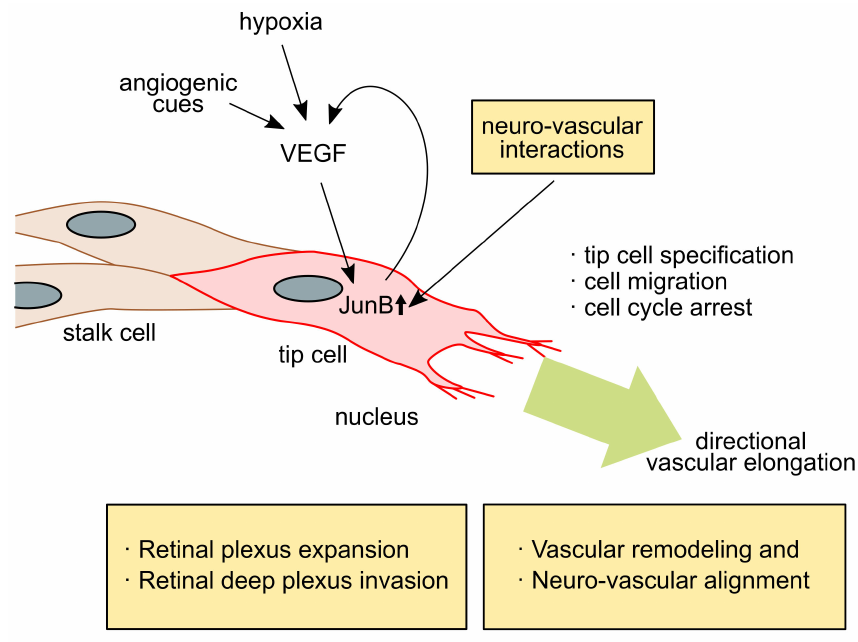
Figure 1. In the event of angiogenesis in embryonic skin and retina, endothelial cells respond to angiogenic cues, such as hypoxia or other signals, to produce new vessel branches at the angiogenic frontier. The vascular endothelial growth factor (VEGF) plays a central role in this process. The VEGF signals that induce JunB expression (small upper arrow) result in the conversion of endothelial cells to tip cells. JunB activation is involved in the vessel parallel alignment with neurons in developing skin, retinal tissue-specific radial vessel expansion, and deep plexus expansion in retinal vessel development. Both vessel-wiring processes in embryonic skin and the retina include neurovascular interactions. The arrows indicate the relationship of signaling directions. Large green arrow indicates direction of vascular